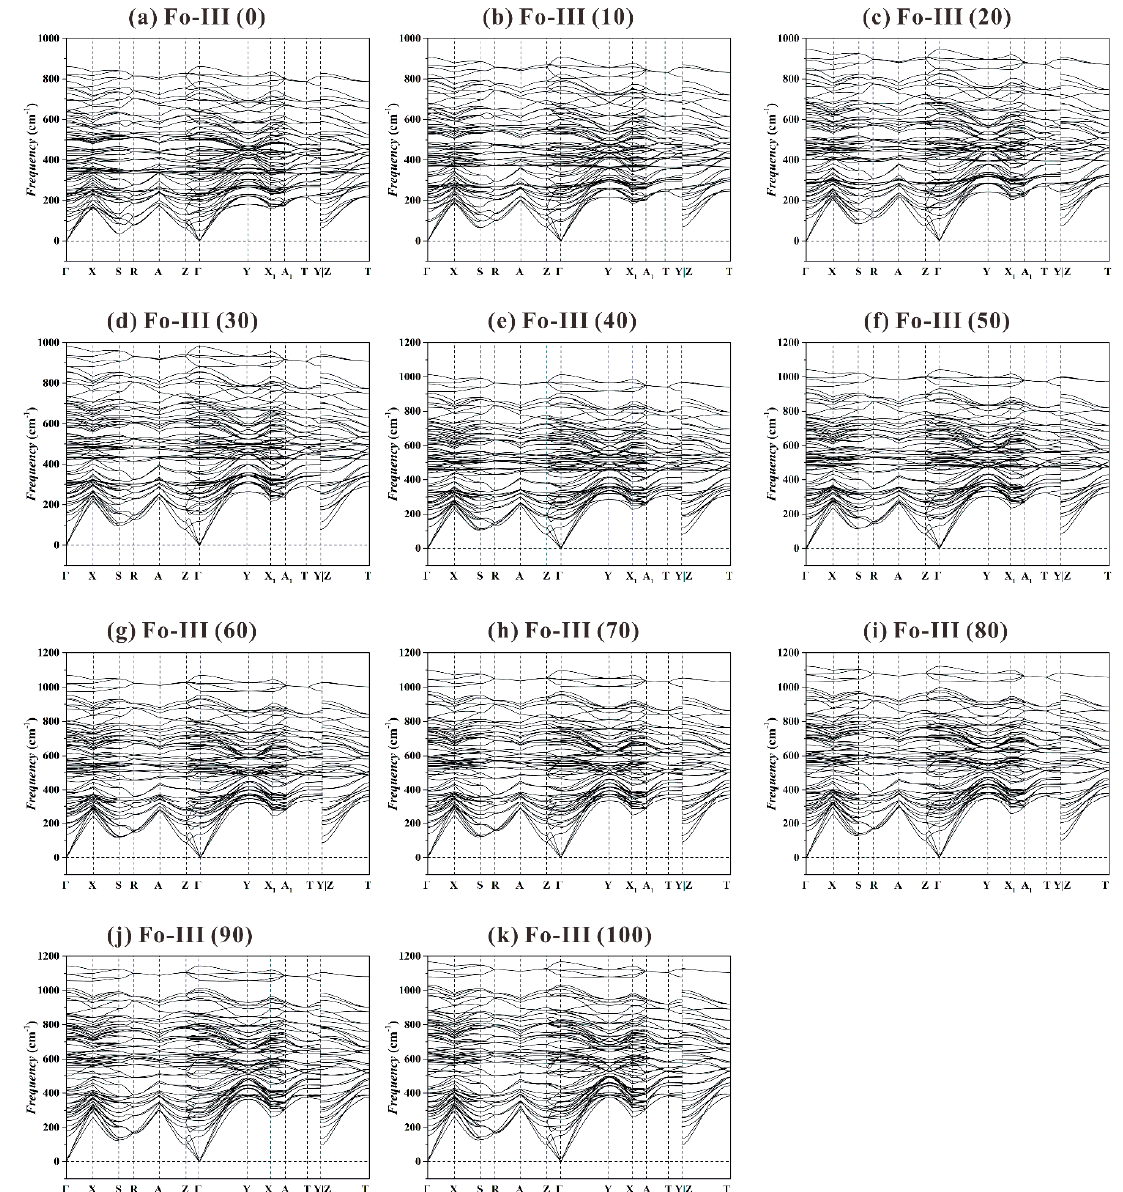
Figure 10. Calculated phonon dispersion curves for Fo-III from 0 to 100 GPa with a k -path Γ -X-S-R-A-Z- Γ -Y-X 1 -A 1 -T-Y|Z-T: ( a ) Fo-III at 0 GPa; ( b ) Fo-III at 10 GPa; ( c ) Fo-III at 20 GPa; ( d ) Fo-III at 30 GPa; ( e ) Fo-III at 40 GPa; ( f ) Fo-III at 50 GPa; ( g ) Fo-III at 60 GPa; ( h ) Fo-III at 70 GPa; ( i ) Fo-III at 80 GPa; ( j ) Fo-III at 90 GPa; ( k ) Fo-III at 100 GPa. The corresponding coordinates are Γ (0, 0, 0), X(0.27, 0.27, 0), S(0, 0.5, 0), R(0, 0.5, 0.5), A(0.27, 0.27, 0.5), Z(0, 0, 0.5), Y( − 0.5, 0.5, 0), X 1 ( − 0.27, 0.73, 0), A 1 ( − 0.27, 0.73, 0.5) and T( − 0.5, 0.5, 0.5).